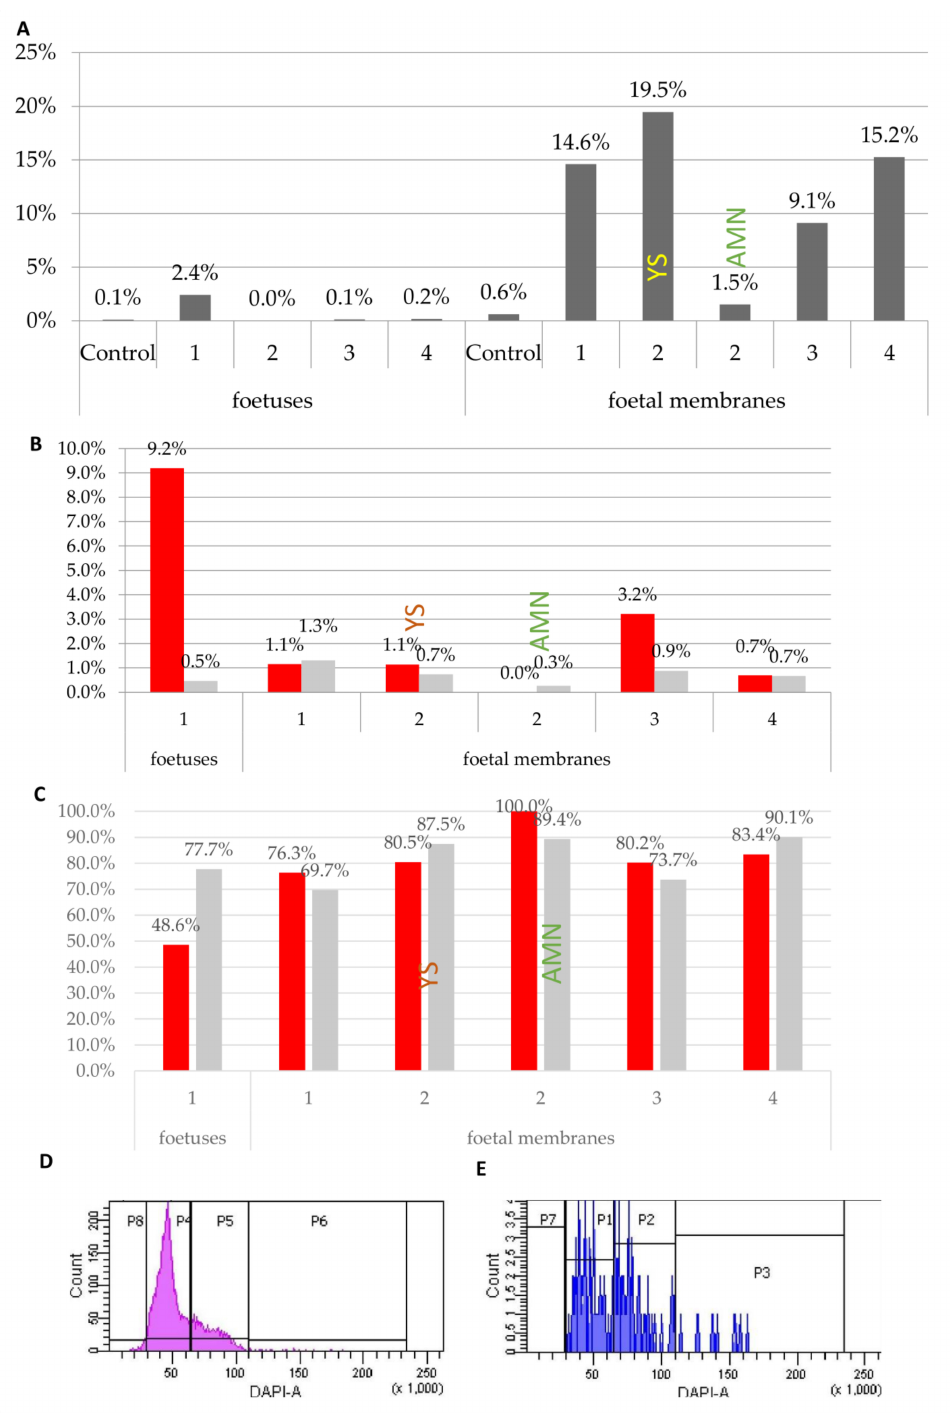
Figure 8. Analysis of donor marker expression in foetuses and foetal membranes. ( A ) Percentage of RFP-expressing cells in foetuses and foetal membranes. Statistically significantly more RFP-positive cells in samples compared to control were found in a chi-square test p < 0.01: embryo 1, foetal membranes 1, yolk sac 2, foetal membranes 3, foetal membranes 4. ( B ) Percentage of confirmed tetraploid cells in G2/M cell cycle phase within foetuses and foetal membranes in which a significant number of RFP-expressing cells were found. ( C ) Percentage of diploid cells in G1 cell cycle phase within RFP-expressing and RFP-negative cells in samples, in which RFP-expressing samples were found. ( D ) Cell cycle analysis of RFP-negative cells in foetus 1: P8: <2c DNA, P4: G1 of 2n cells, P5: G2/M of 2n cells and G1 of 4n cells, P6: G2/M of 4n cells. ( E ) Cell cycle analysis of RFP-expressing cells in foetus 1: P7: < 2c DNA, P1: G1 of 2n cells, P2: G2/M of 2n cells and G1 of 4n cells, P3: G2/M of 4n